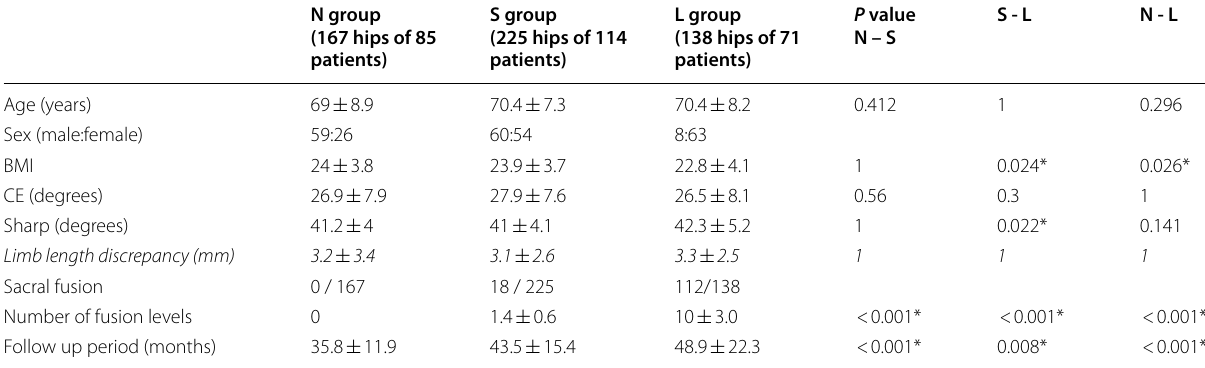
SD standard deviation, BMI body mass index, CE center